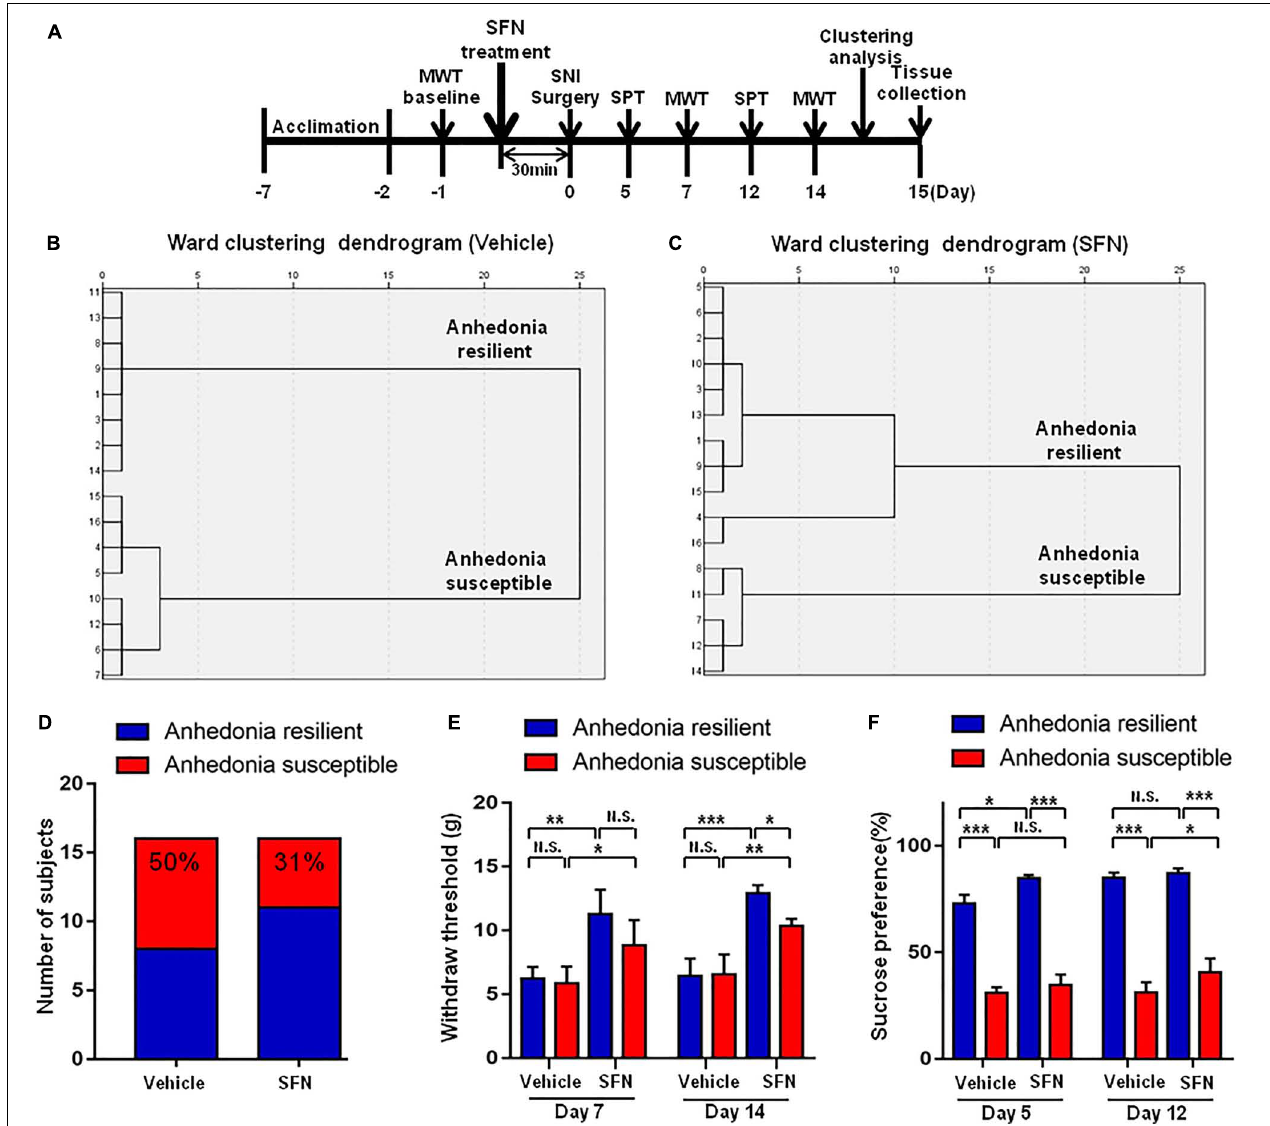
FIGURE 5 | Effects of SFN treatment before SNI surgery on the results of MWT and SPT. (A) The schedule of this study. SNI was performed on day 0 after acclimation. SFN at a single dose of 30 mg/kg was administered 30 min before SNI surgery. MWT was measured on day 5 and 12 after SNI, respectively. SPT was performed on day 7 and 14 after SNI, respectively. (B) Dendrogram of hierarchical clustering analysis. A total of 16 SNI rats were divided into anhedonia-susceptible and anhedonia-resilient groups by SPT results. Eight of 16 SNI rats were anhedonia susceptible phenotype. (C) Dendrogram of hierarchical clustering analysis. A total of 16 SNI rats were divided into anhedonia-susceptible and anhedonia-resilient groups by SPT results. Five of 16 SNI rats were anhedonia-susceptible phenotype. (D) Ratio of anhedonia-susceptible rats to total SNI rats. The ratio of anhedonia-susceptible rats in vehicle and SFN groups were 50 and 31%, respectively. (E) MWT [Time: F ( 1 , 16 ) = 8.851 , P = 0.0089; SFN: F ( 3 , 16 ) = 30.58 , P < 0.001; Interaction: F ( 3 , 16 ) = 0.9991 , P = 0.4186]. Data are shown as mean ± SEM ( n = 5). ∗ P < 0.05, ∗∗ P < 0.01 or ∗∗ P < 0.001. (D) SPT [Time: F ( 1 , 16 ) = 32.05 , P < 0.001; SFN: F ( 3 , 16 ) = 361.7 , P < 0.001; Interaction: F ( 3 , 16 ) = 7.569 , P = 0.0023]. Data are shown as mean ± SEM ( n = 5). MWT, mechanical withdrawal test; N.S., not significant; SFN, sulforaphane; SNI, spared nerve injury; SPT, sucrose preference